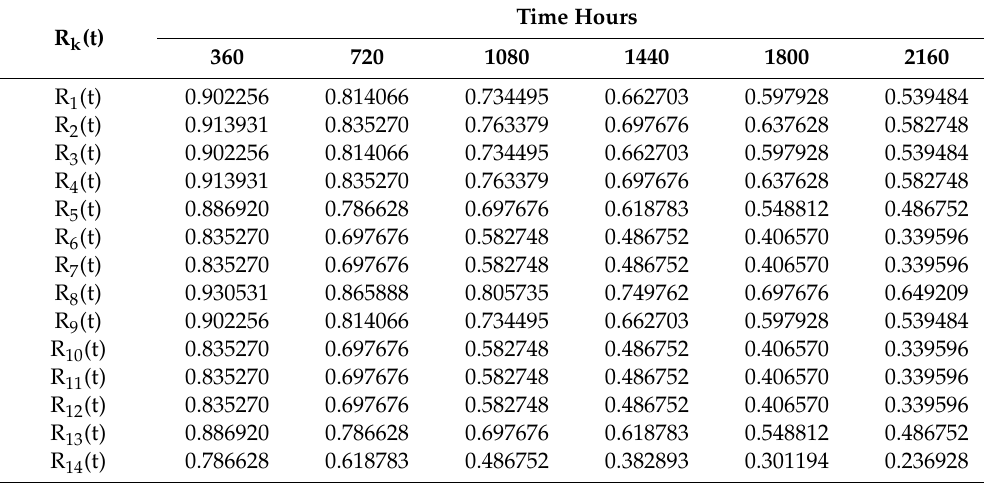
Table 8. Variation of components’ reliability during di ff erent operational